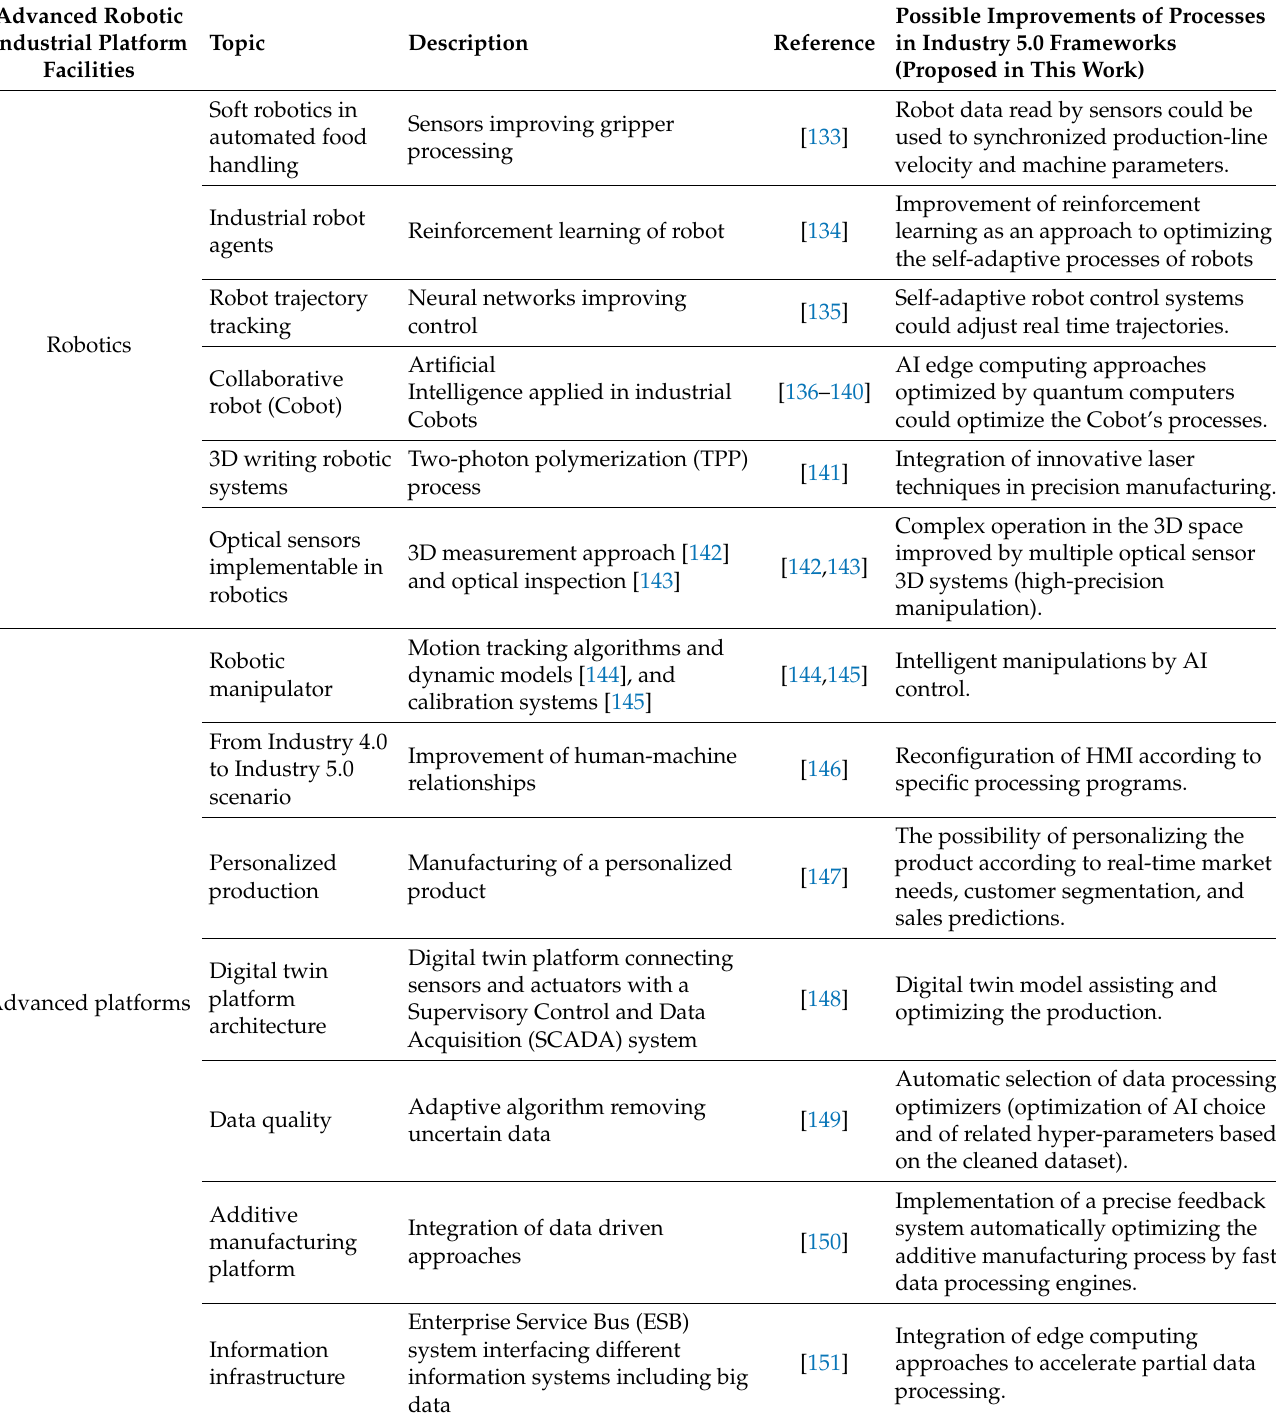
Table 5. State of the art: advanced robotic systems and technological platforms, and Industry 5.0